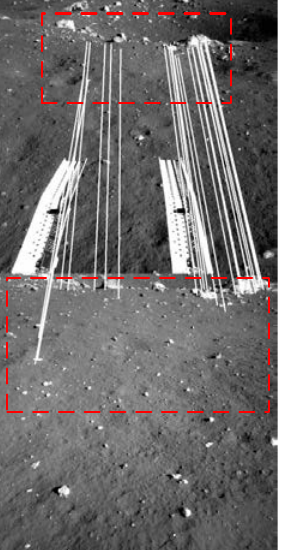
Figure 4. Feature matching in cross-site images